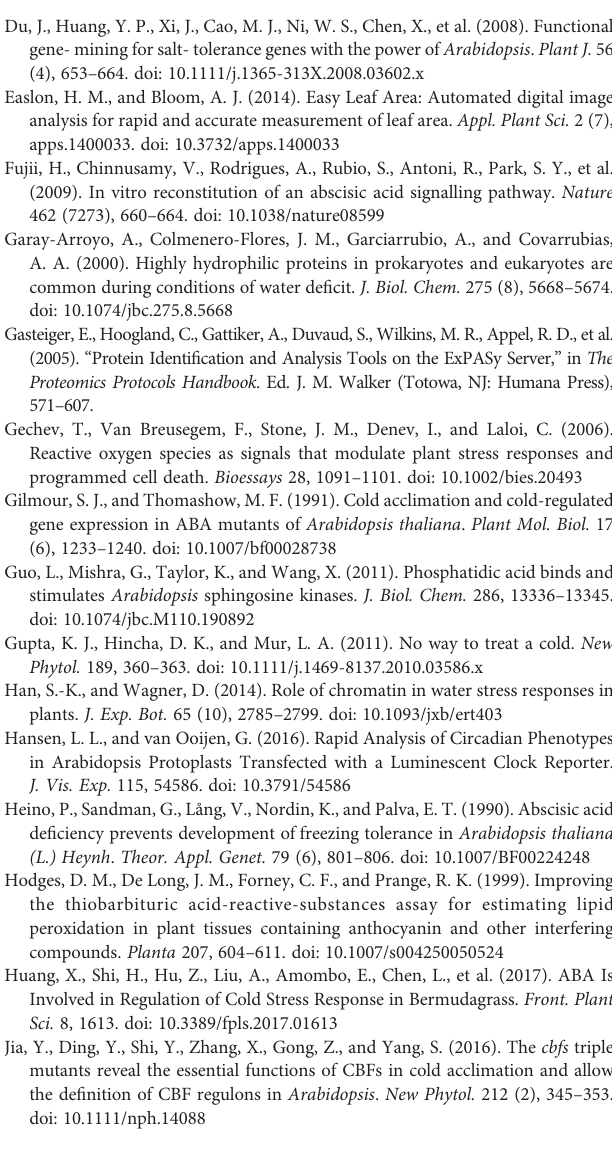
were programmed to get the blank for homozygous mutant and for wild type plants, respectively. The complete reaction with the three oligonucleotides (LP +BP+RP) produces one ampli fi ed fragment of 900 bp for the wild type and one of 700 bp for the homozygous mutant. B: RT-PCR (left panel) and RT-qPCR (right panel) were used to verify the lack of STRP expression in the strp mutant. The PCR were performed with the following primer pairs: 5 ’ - CCATCTCTTAACTCTTCCATCCAA-3 ’ , and 5 ’ -TCTGGCTCCTCTGGTGTT-3 ’ . mRNA levels were normalized to GAPDH mRNA. Error bars are S.E.M. of three independent experiments. *P < 0.01, by Student ’ s t-test. C: western blot analysis, FIGURE S3 | Densitometric analysis of bands of western blot experiments. Densitometric analysis was performed using the ImageJ image-processing program. Data are expressed as the percentage of the maximum integrated densitometric value (IDV, the product of the area and mean grey